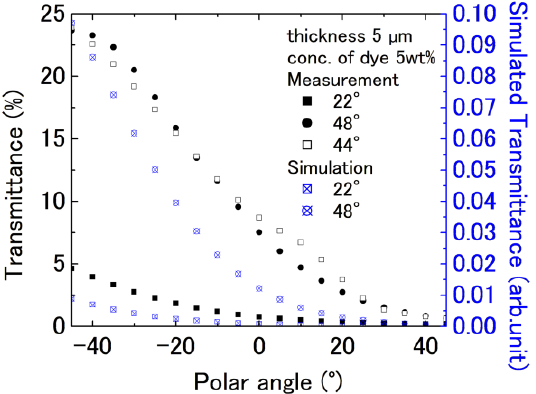
Figure 8. Angle dependence of transmittance for GHLC cells with high pretilt angles. Black squares, black circles, and open squares, respectively, indicate measured data for pretilt angles of 22°, 48°, and 44°. Square-enclosed crosses and circle-enclosed crosses, respectively, indicate simulation results for pretilt angles of 22° and 48°.